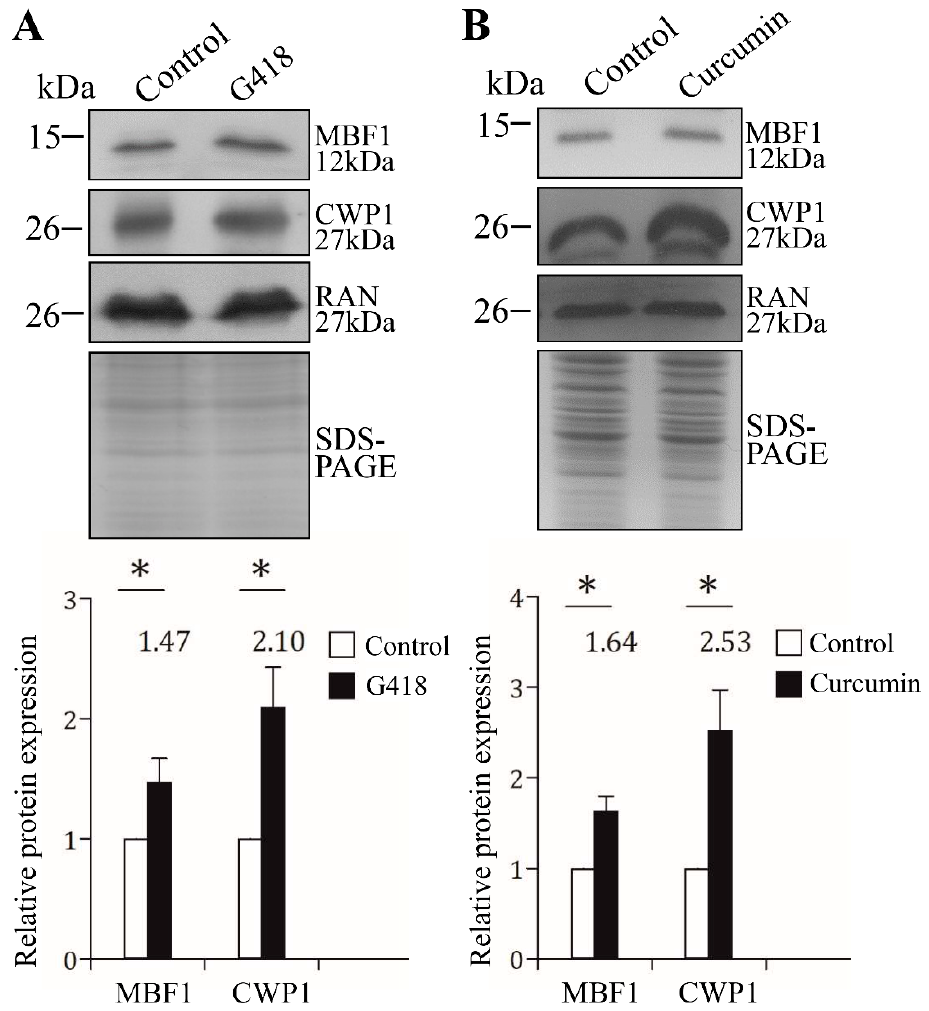
Figure 9. G418 and curcumin treatment increased the levels of MBF1 and CWP1 proteins. The wild-type non-transfected WB cells were cultured in growth medium containing ( A ) 217 µM G418 or ( B ) 200 µM curcumin for 24 h using the same volume of ( A ) H 2 O or ( B ) Me 2 SO as a solvent control and then subjected to SDS-PAGE and Western blot analysis. The blot was probed with anti-MBF1, anti-CWP1, and anti-RAN antibodies, respectively. The intensity of bands was quantified as described in Figure 2B. *, p < 0.05.